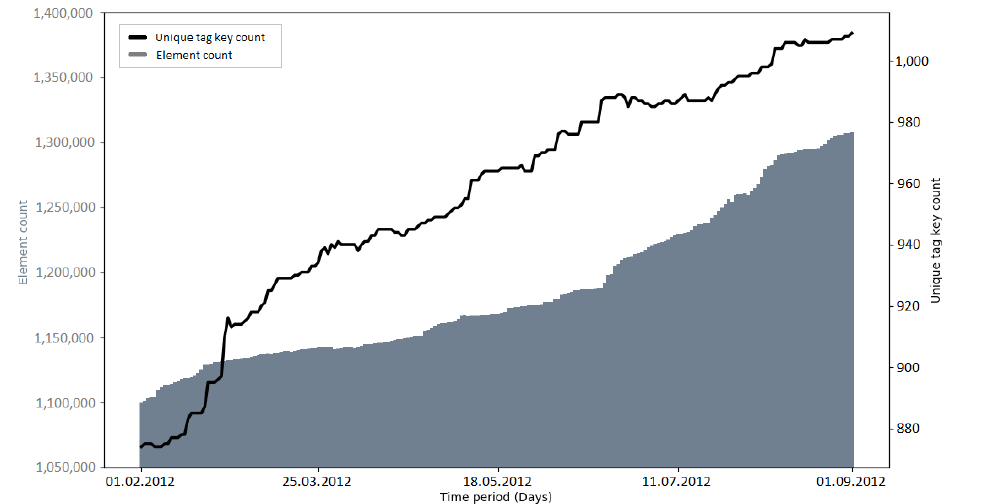
Figure A23. Number of tag keys during the observation period without a large data import in